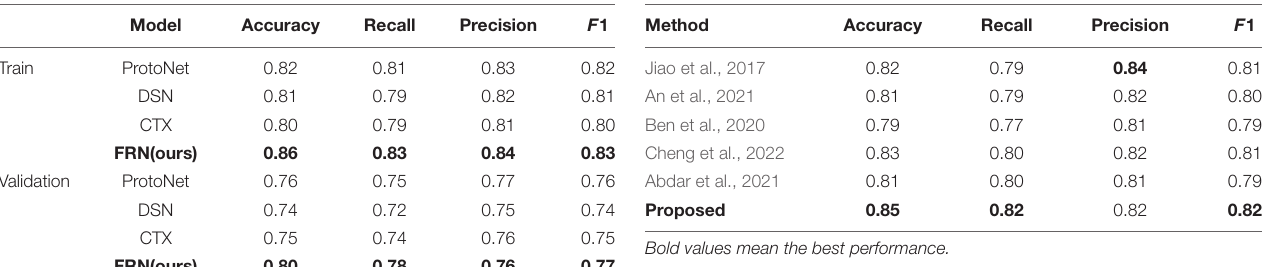
TABLE 3 | Results comparison with different classifiers. TABLE 4 | Results comparison with typical methods.